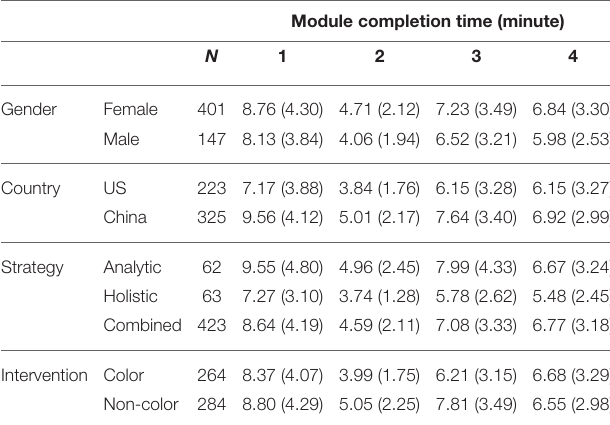
TABLE 4 | Descriptive statistics for 548 participants (response